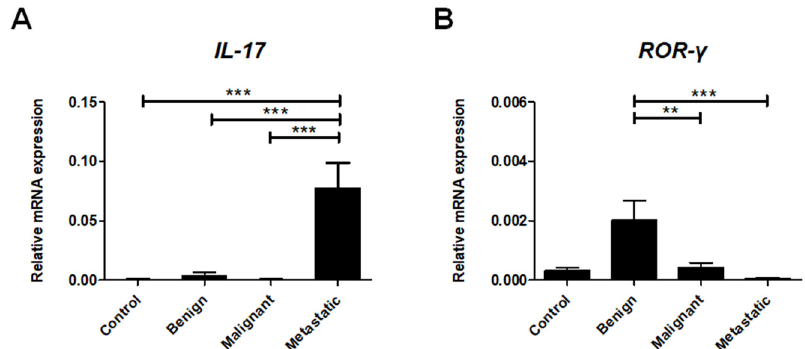
Figure 6. Th17 cell-associated gene expression levels in canine mammary tumors. Relative gene expression of ROR- γ t ( A ) and IL-17 ( B ) in healthy mammary gland tissue (Control) and in benign, malignant, and metastatic canine mammary tumors. The results are presented as the mean ± SEM. A one-way ANOVA and Tukey HSD post hoc test were applied. Significance levels are indicated as follows: * p < 0.05; ** p < 0.01; *** p <